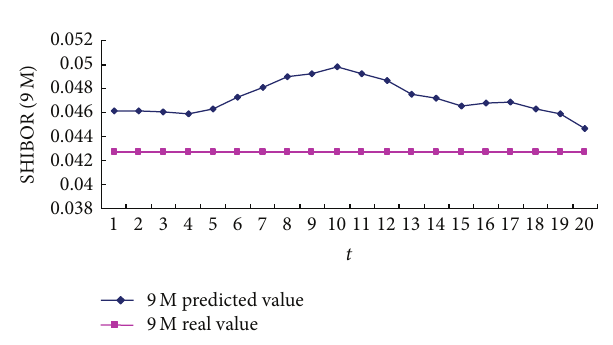
Figure 7: Nine-month SHIBOR forecast figure.